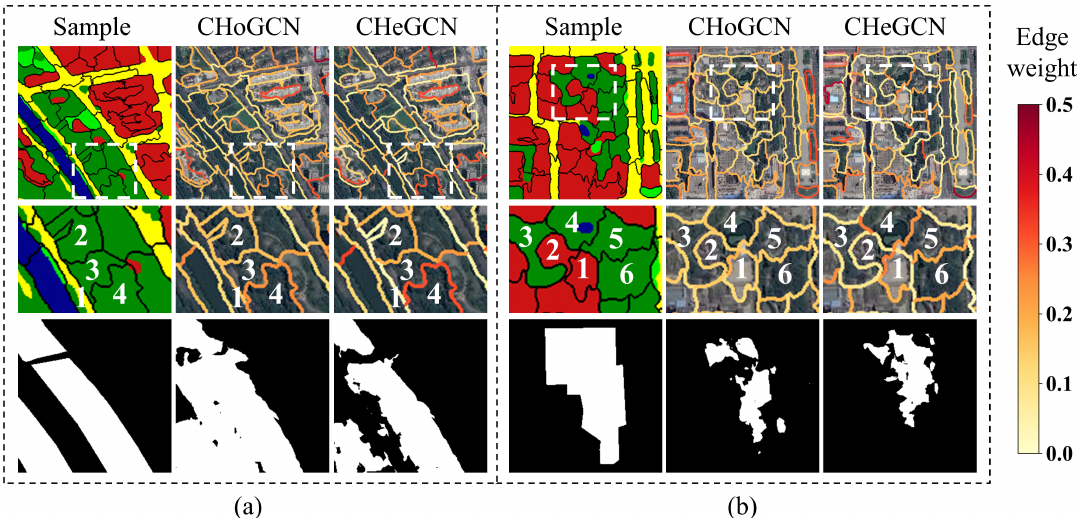
Figure 7. Visualization of edge weights among land cover objects and the segmentation results. There are two examples shown in ( a , b ) and the numbers in the second row denote the index numbers of different nodes. The color bar on the right is used to render edge weights, with higher values making edges